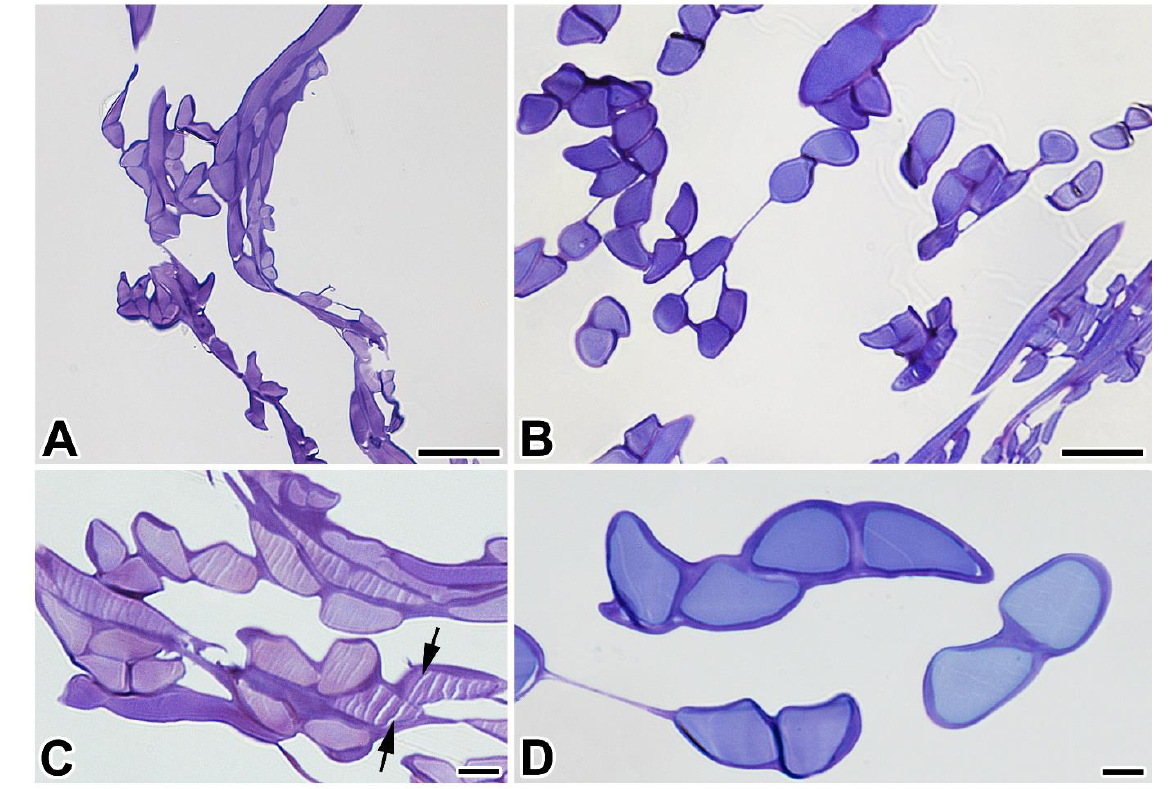
Figure 3. Light microscopy of toluidine-blue stained semi-thin sections of ( A , C ) P. prasinana and ( B , D ) B. mori cocoons. The inner fibroin (lighter) and outer sericin (darker) layers can be distinguished. Arrowheads in the figure C point to parallel cracks that could be artifacts related to knife marks. Scale-bars : ( A , B ) 20 μm; ( C , D ) 5 μm.